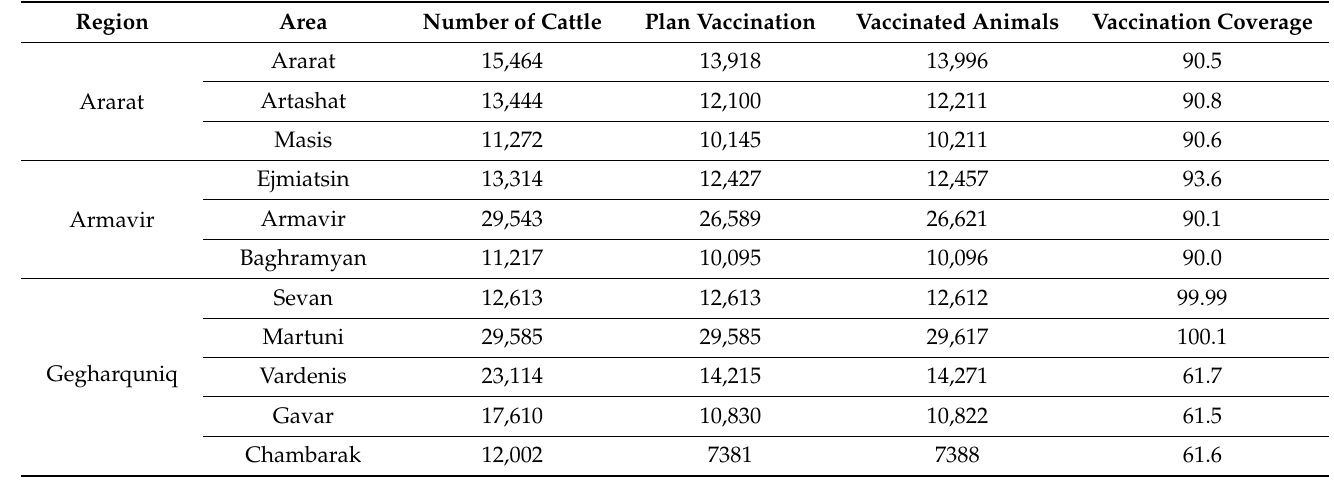
Table 1. Regions covered in this study, the planned number for vaccination, and the numbers of fully vaccinated animals in 2020. Vaccination occurred April–June